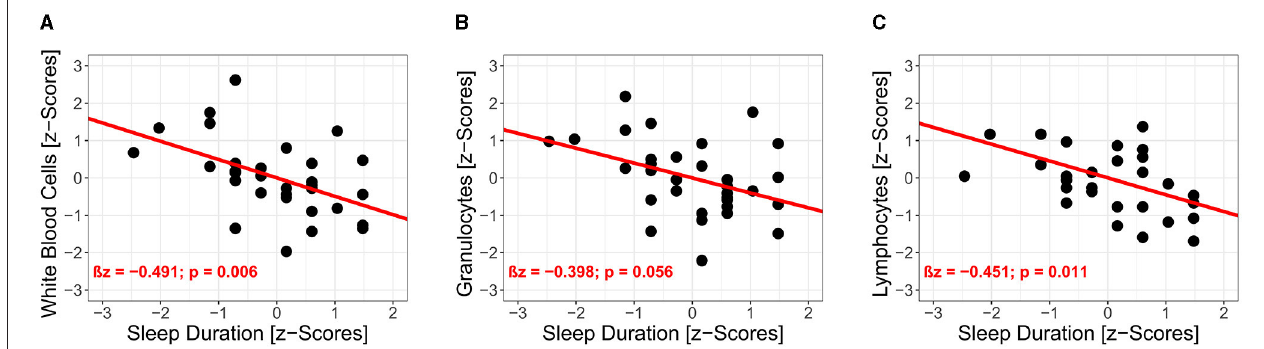
FIGURE 4 | Interrelations of post-training to morning immune regulation in capillary blood markers and sleep duration. Results of the univariate regression analyses are illustrated for white blood cells (A) , granulocytes (B) and lymphocytes (C) .